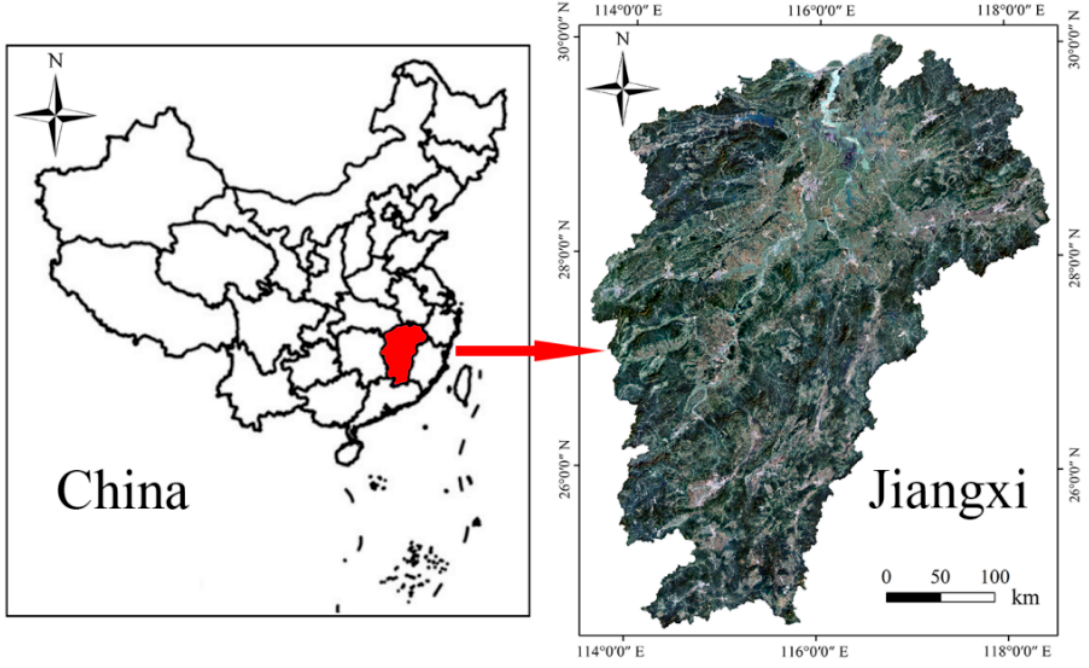
Figure 1. Aerial images of Jiangxi province.